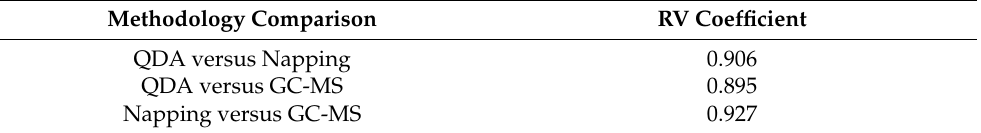
Table 2. RV coefficient from the HMFA comparison of the QDA, Napping and GC-MS